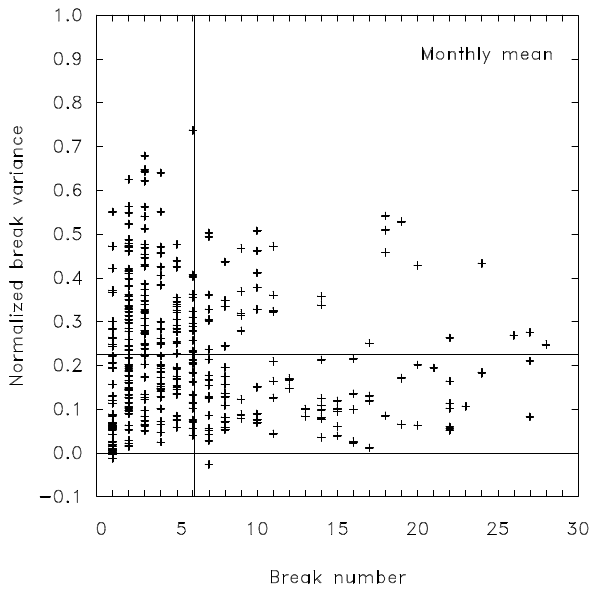
Figure 7. Estimation of the break variance and the number of breaks for monthly mean temperature. The estimation is given for 443 different German station pairs. The vertical line denotes the mean break number (6.1) found for all stations, and the horizon- tal lines mark zero variance and the average explained normalized variance (0.22),